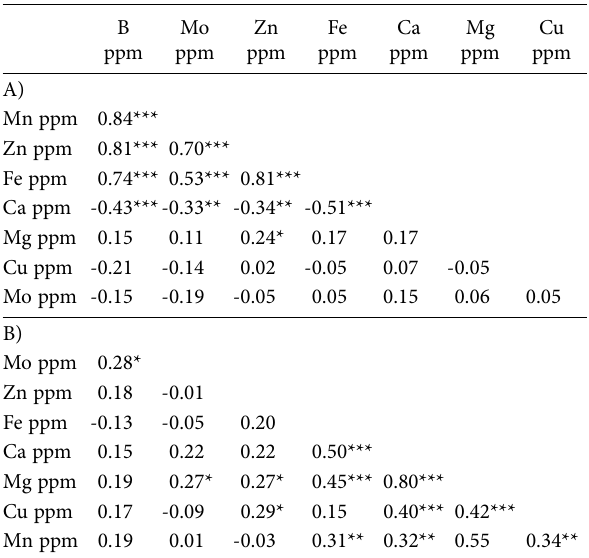
Table 3. Pearson correlation matrix among the variables for soil (A) and olive leaf (B) samples. *,**,*** indicate significance at P < 0.05, P < 0.01 and P < 0.001.